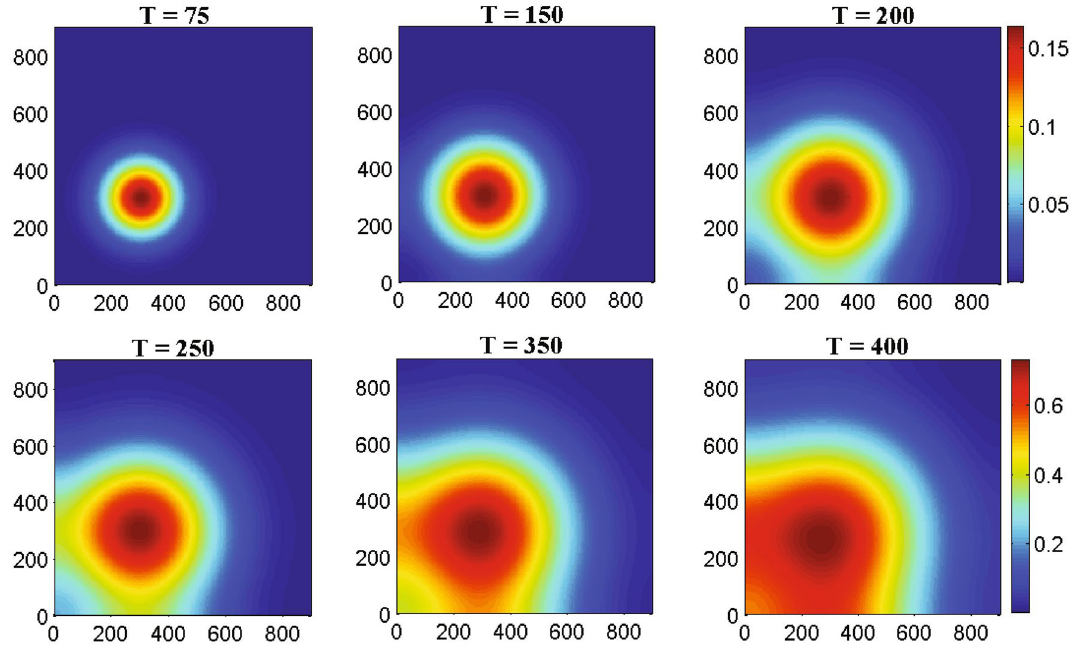
Figure 5. The two-dimensional numerical simulations describe the dynamics of glioma cells density G ( t , x , y ) at times corresponding to 75, 150, 200, 250, 350 and 400 h respectively. The simulation demonstrates the spatial distribution of glioma cells density through the domain for an increasing value of time. Parameter values: D G = 55 , D M = 5 , D T = 400 , D C = D I = 25 and the other parameter values and initial conditions are presented in the Table